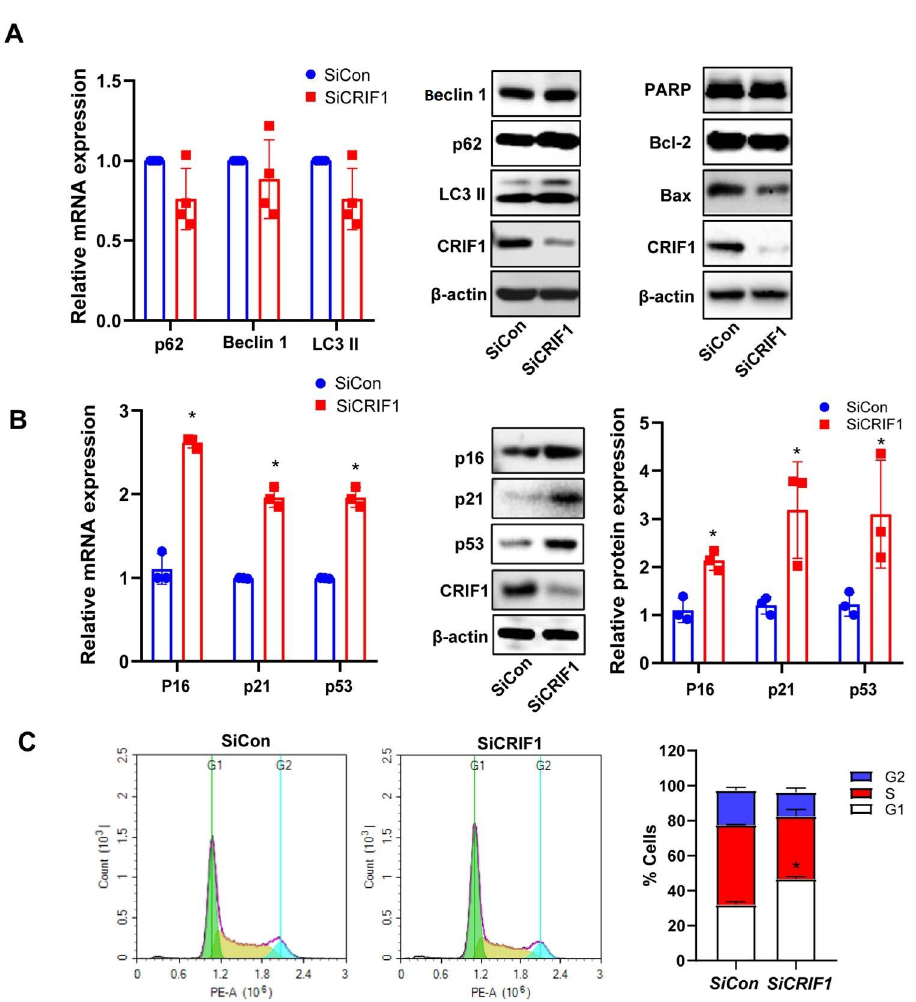
Figure 3. CRIF1 deficiency regulated cell cycle progression but did not affect autophagy or apoptosis in MCF-7 cells. MCF-7 cells were transfected with 100 pmol of siCon and siCRIF1 for 48 h. ( A ) mRNA expressions of p62, beclin1, LC3II were detected by qPCR. Autophagy and apoptosis-related proteins were detected by immunoblotting. ( B ) mRNA expressions of p16, p21, p53 were detected by qPCR. p16, p21, and p53 protein expression were detected by immunoblotting and then quantified by densitometric analysis. ( C ) Cell cycle status was detected by using FACS analysis. Green shows G1 phase, yellow shows S phase, and blue shows G2 phase. All data are presented as means ± SEM of at least three independent experiments. * p < 0.05 compared with siCon